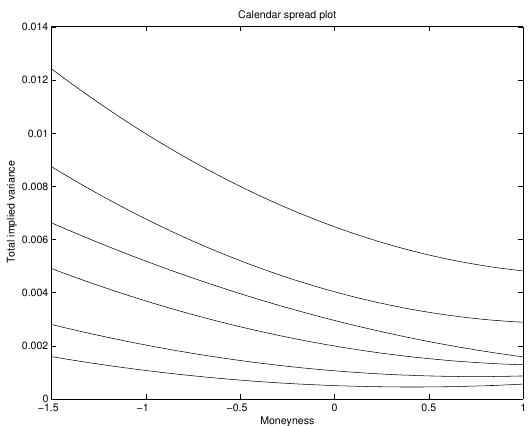
Figure 1. Plots of the total implied variance for six different times to maturity following the forward slice-by-slice method of Section 4.3.